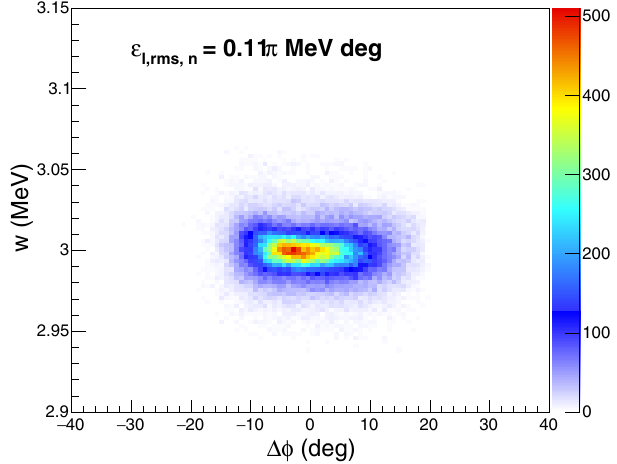
FIG. 3. Simulated longitudinal particle distribution at the exit of the RFQ.